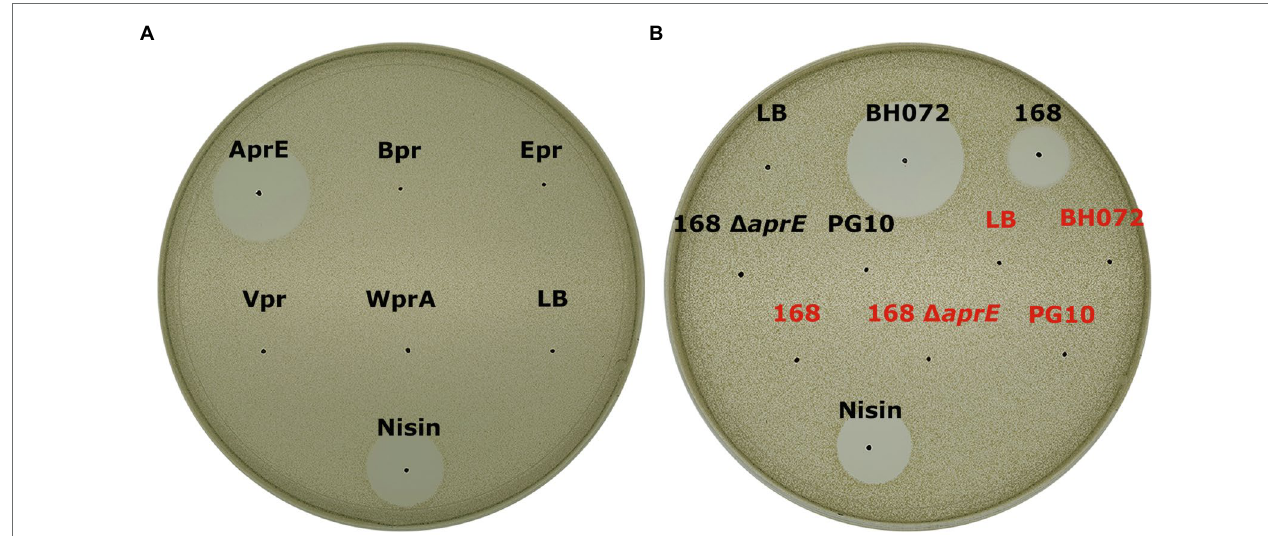
FIGURE 2 | (A) Antimicrobial activity test of fully modified His6-MrsA that has been processed by either AprE, Bpr, Epr, Vpr, or WprA against Micrococcus flavus . Only AprE-processed fully modified His6-MrsA is activated (B) The ability of several overnight culture supernatants to activate mersacidin. The filtered supernatant of B. amyloliquefaciens BH072, B. subtilis 168 , B. subtilis 168 Δ aprE, and B. subtilis PG10 was incubated with either fully modified His6-MrsA (black) or an equal volume of Milli-Q water (red) and spotted against M. flavus . The BH072 supernatant had by far the highest efficacy at activating mersacidin, although